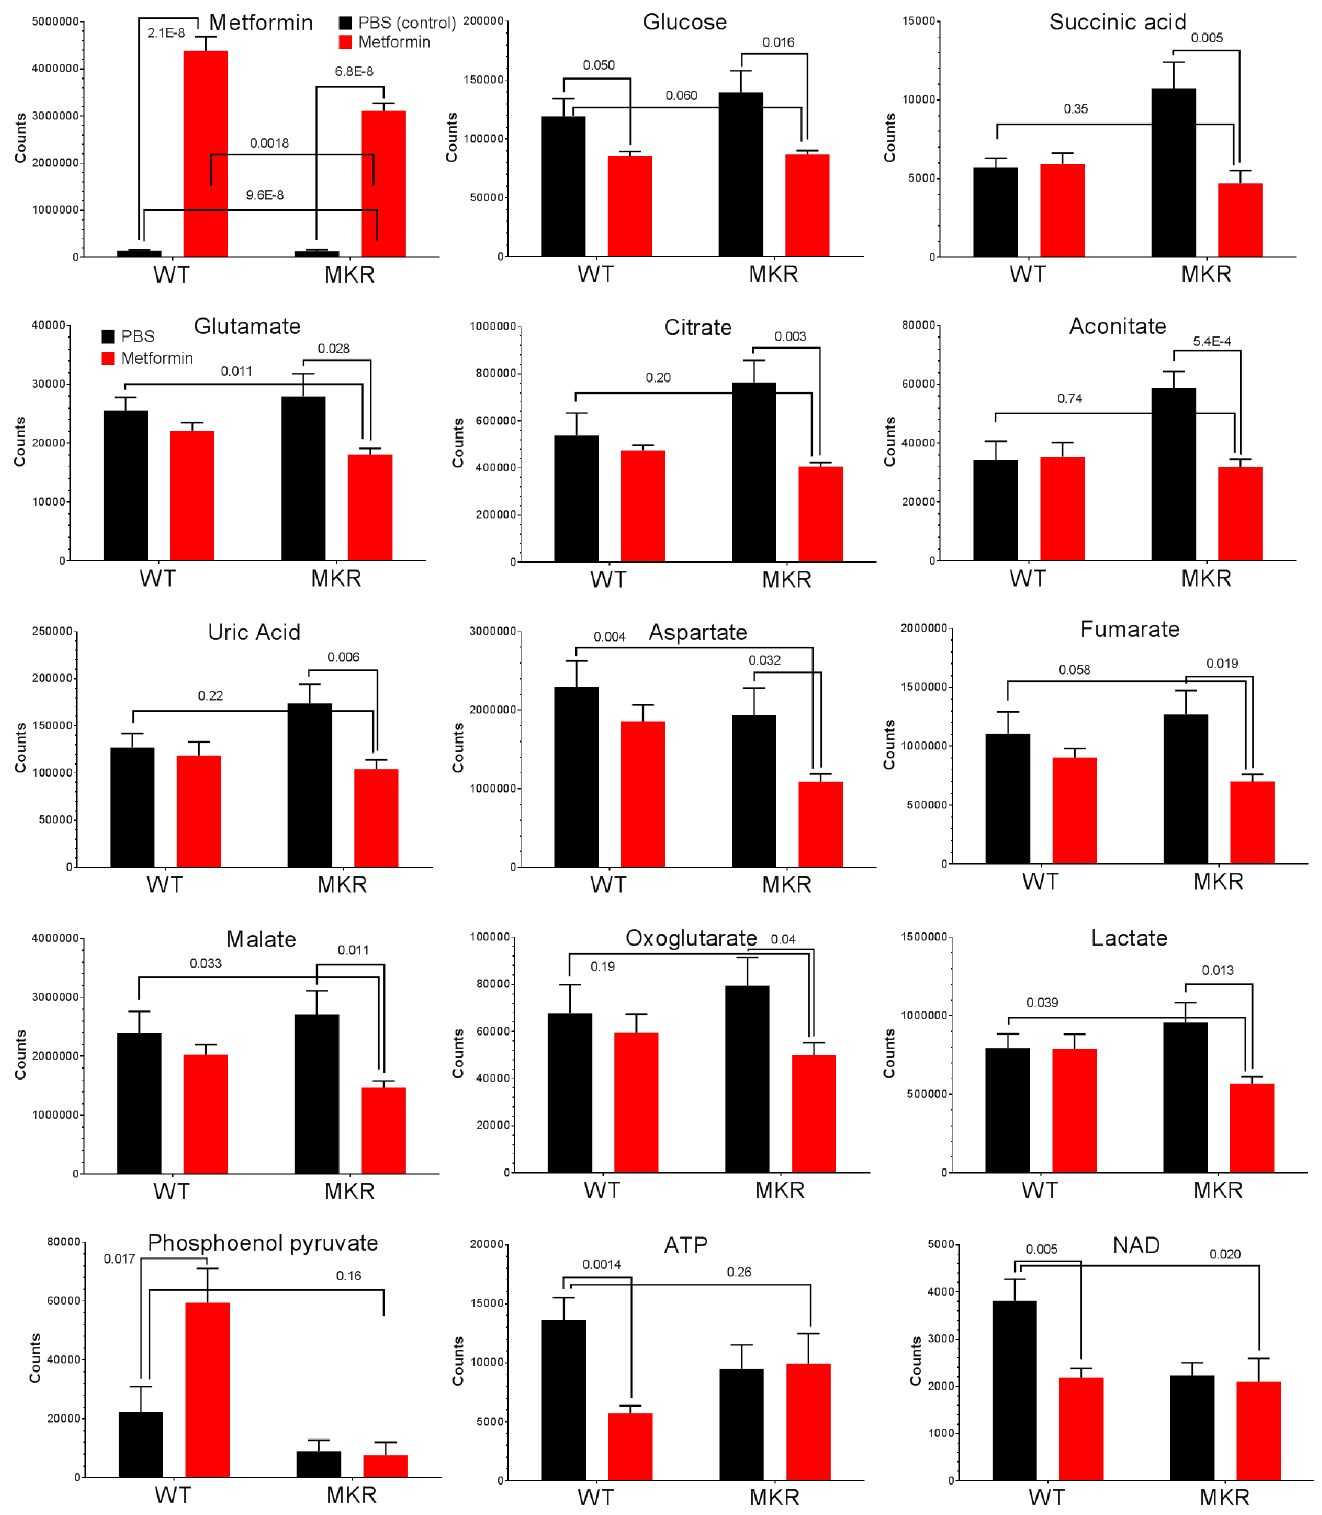
Fig 3. Individual metabolite levels in bone marrow affected by metformin. Each plot shows the mean ± SEM values of respective sample groups for one particular metabolite (n = 4 for WT_PBS, WT_Met, MKR_PBS, n = 3 for MKR_Met, each sample with technical triplicates). The p-values for t-test (two-tailed, unequal variance) is also showed whenever significant ( < 0.05). Plots were generated in GraphPad Prism 6.